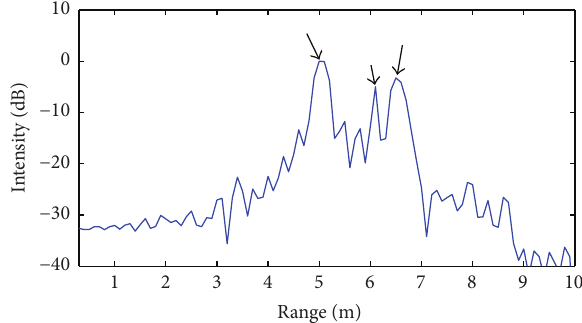
Figure 14: Radar intensity profile obtained from CS processing algorithm: experimental scenario of Figure